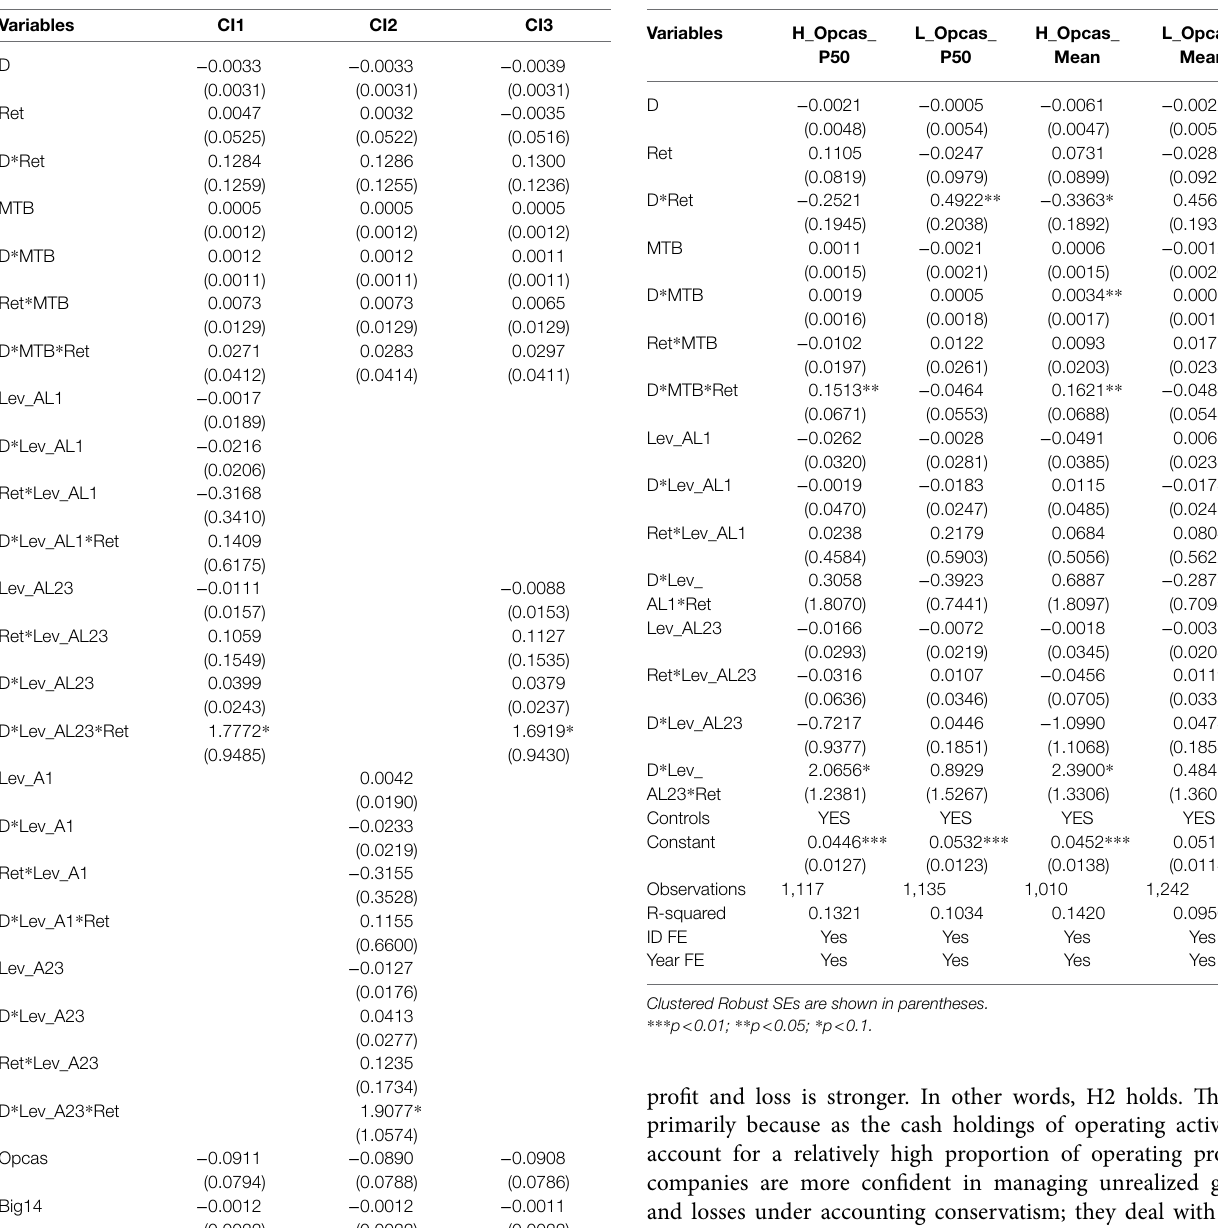
TABLE 5 | Groups based on the percentage of operating cash holdings. TABLE 4 | Regression